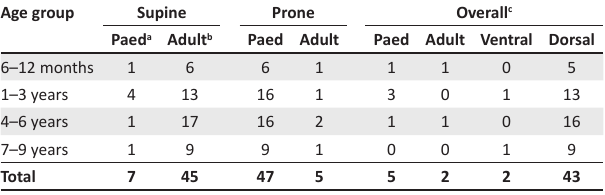
TABLE 3: Number of participants following the paediatric pattern or adult pattern in the supine or prone positions, together with a summary of the overall pattern in the two